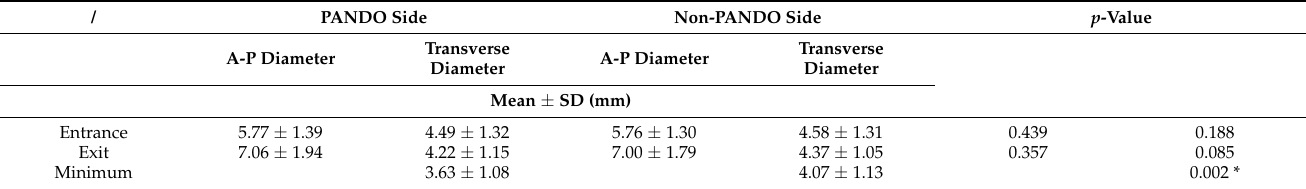
Table 1. Measurements of the bony nasolacrimal duct.